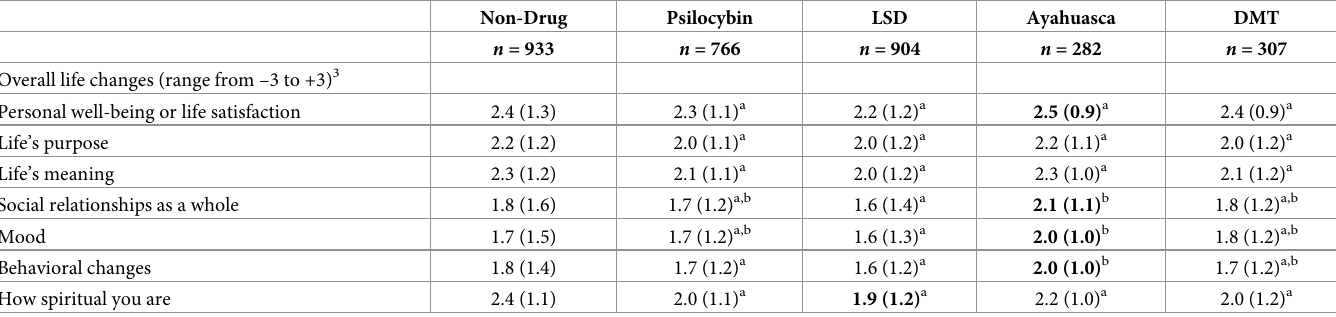
Table 12. Persisting changes attributed to the experience among the Non-Drug, Psilocybin, LSD, Ayahuasca, and DMT groups 1,2